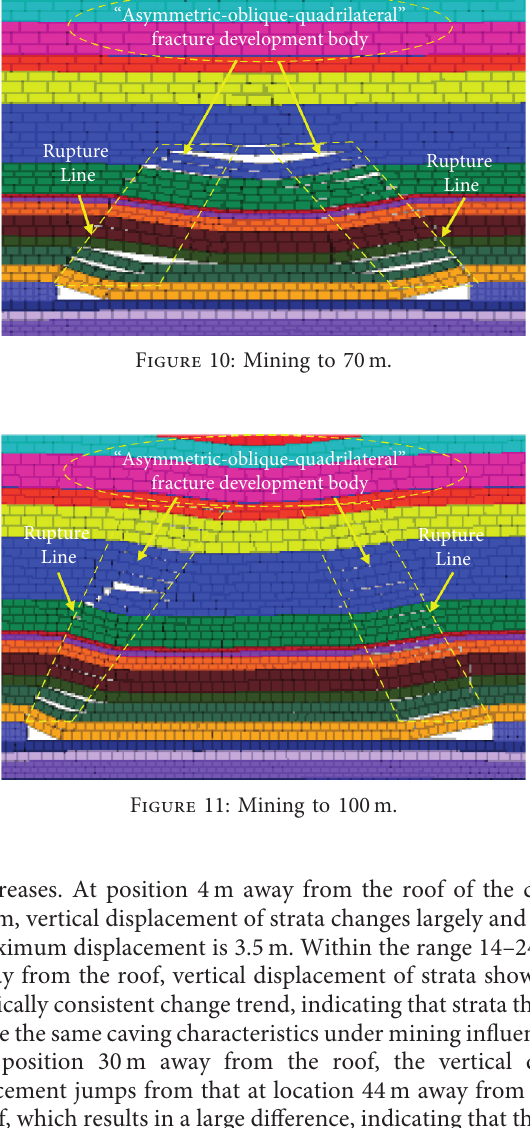
“Asymmetric-oblique-quadrilateral” fracture development body